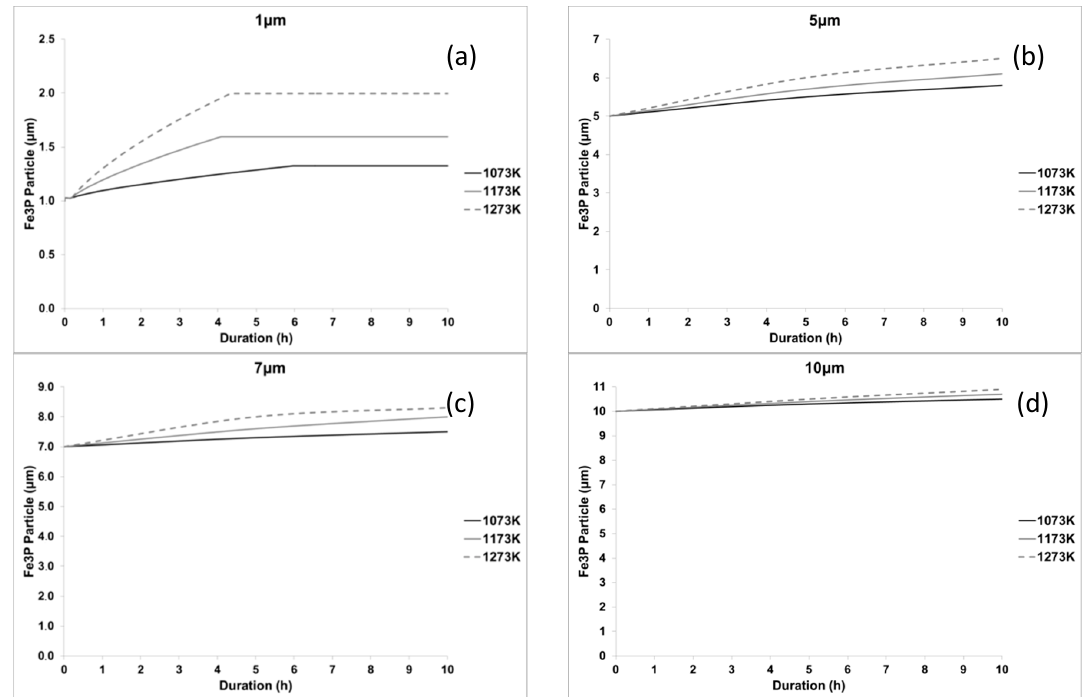
Figure 6. Simulation results of homogenization of Fe 3 P particles in an enriched Cu matrix tested at various temperatures for ( a ) 1 μ m, ( b ) 5 μ m, ( c ) 7 μ m, ( d ) 10 μ m.